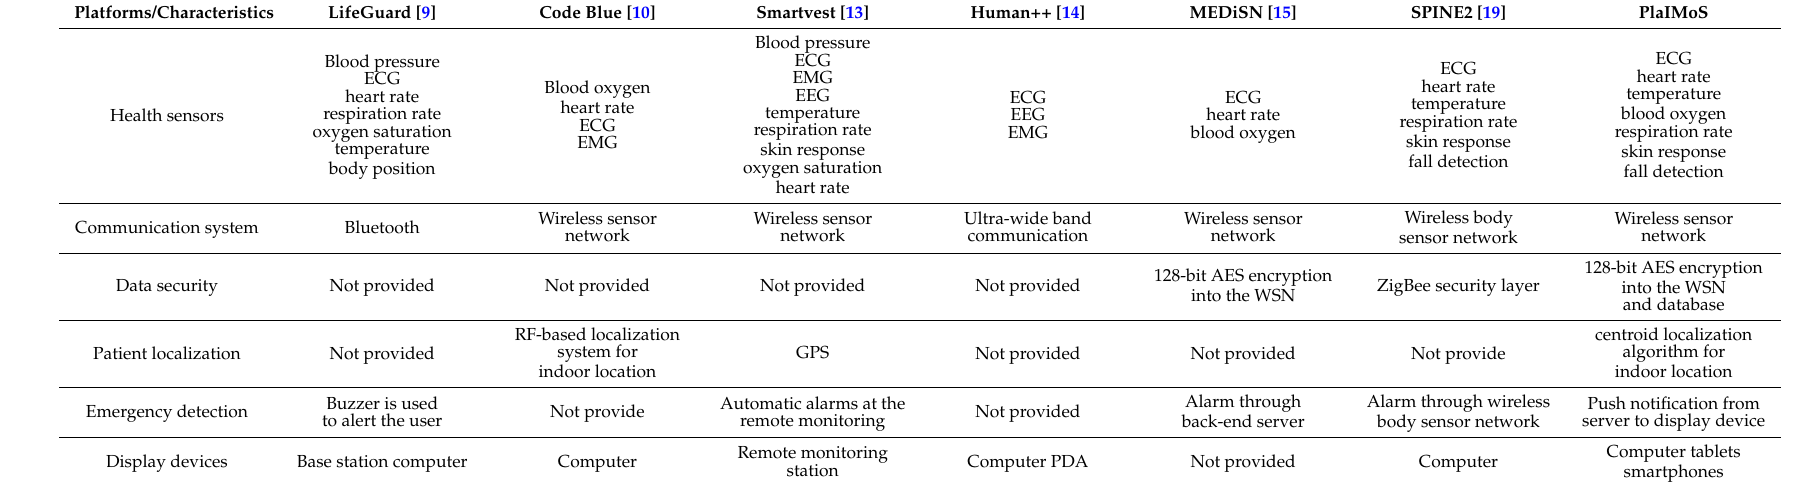
Table 1. e-health platform